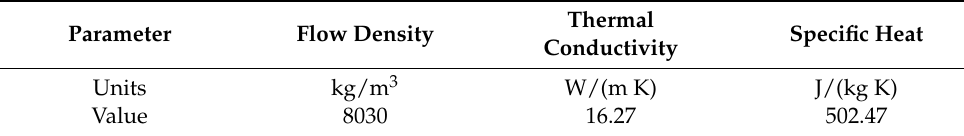
Table 1. Thermodynamic properties of the stainless steel S316L.